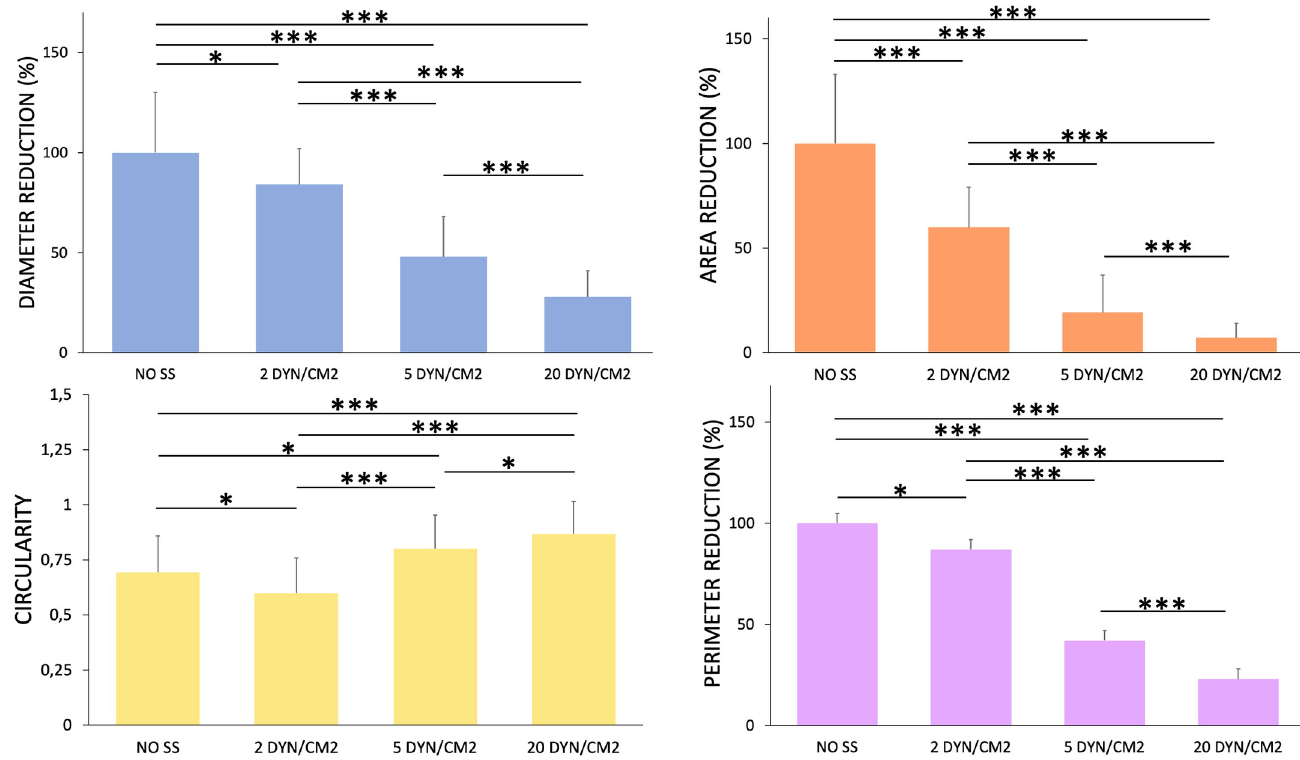
Fig 7. Quantitative analysis of the CTC clusters images. Values are reported as mean ± s.d., N = 4. Student’s t-test. � P < 0.05; ��� P < 0.001.